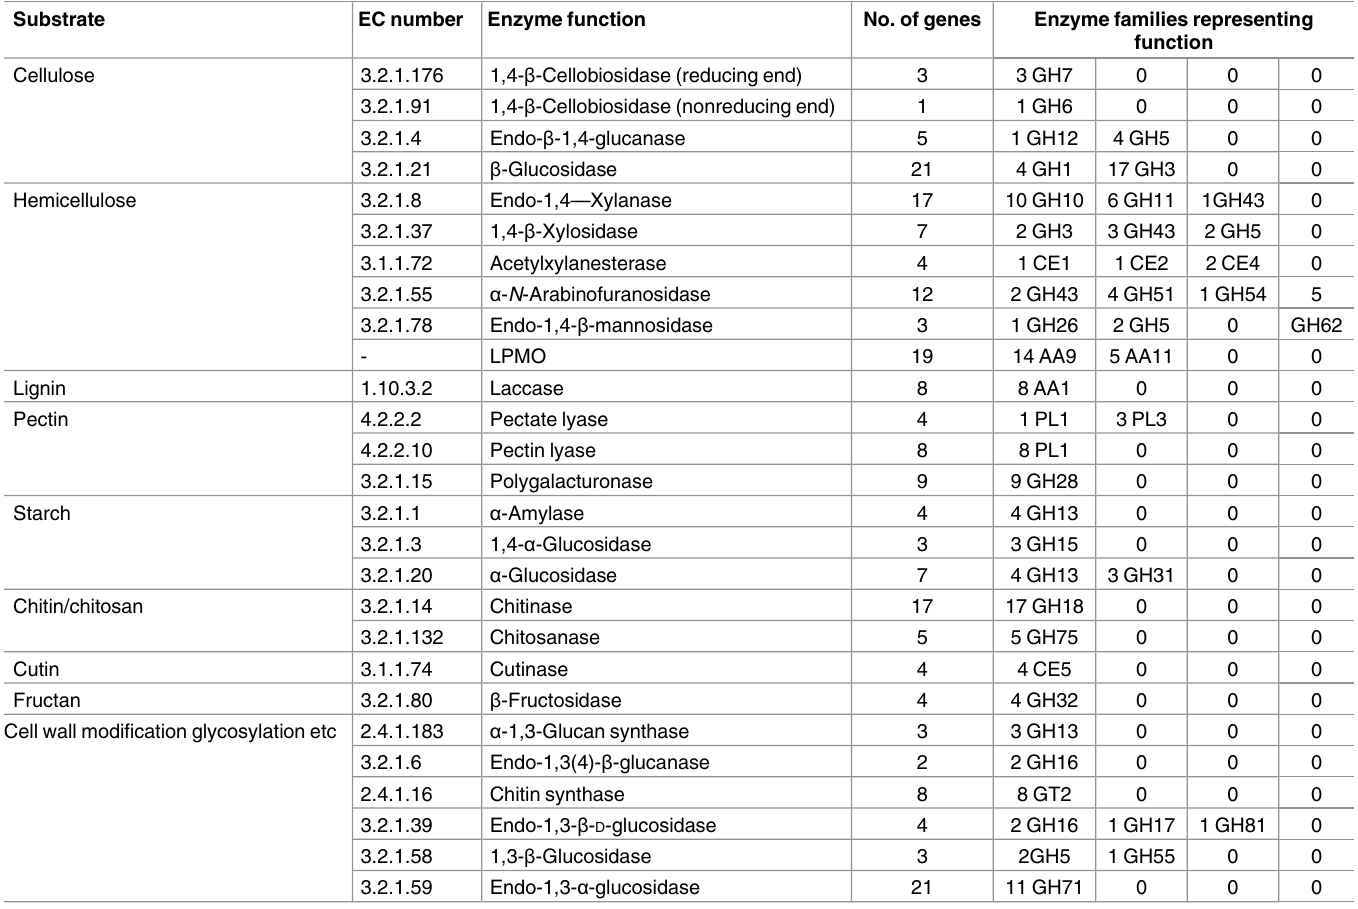
Table 3. Summarised PPR/Hotpep analysis of Aspergillus hancockii FRR 3425 genome with respectto plant polysaccharide degrading enzymes and selected intracellular functions. The enzyme functions are sorted accordingto the substrate on which they normally act. In many cases severalgenes in severaldifferent families represent the same enzymatic function. (See full list of hits in Table B in S1 File). Substrate EC number Enzyme function